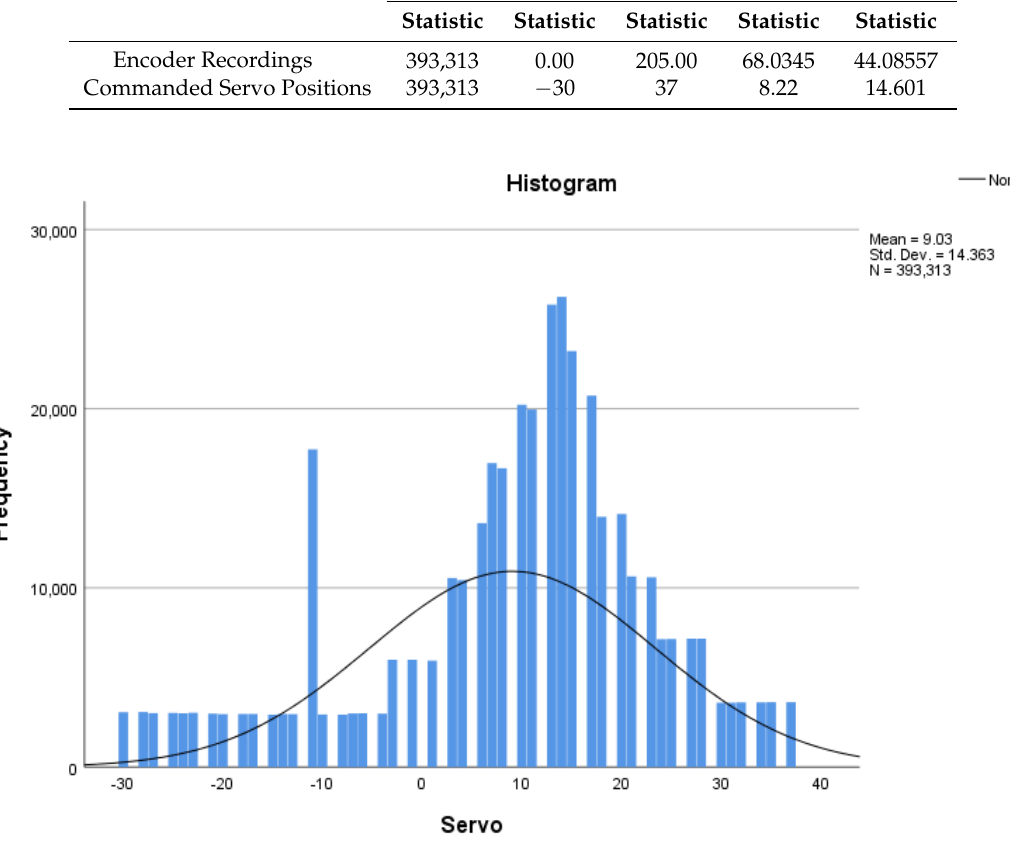
Figure 5. Histogram of commanded servo positions for entire